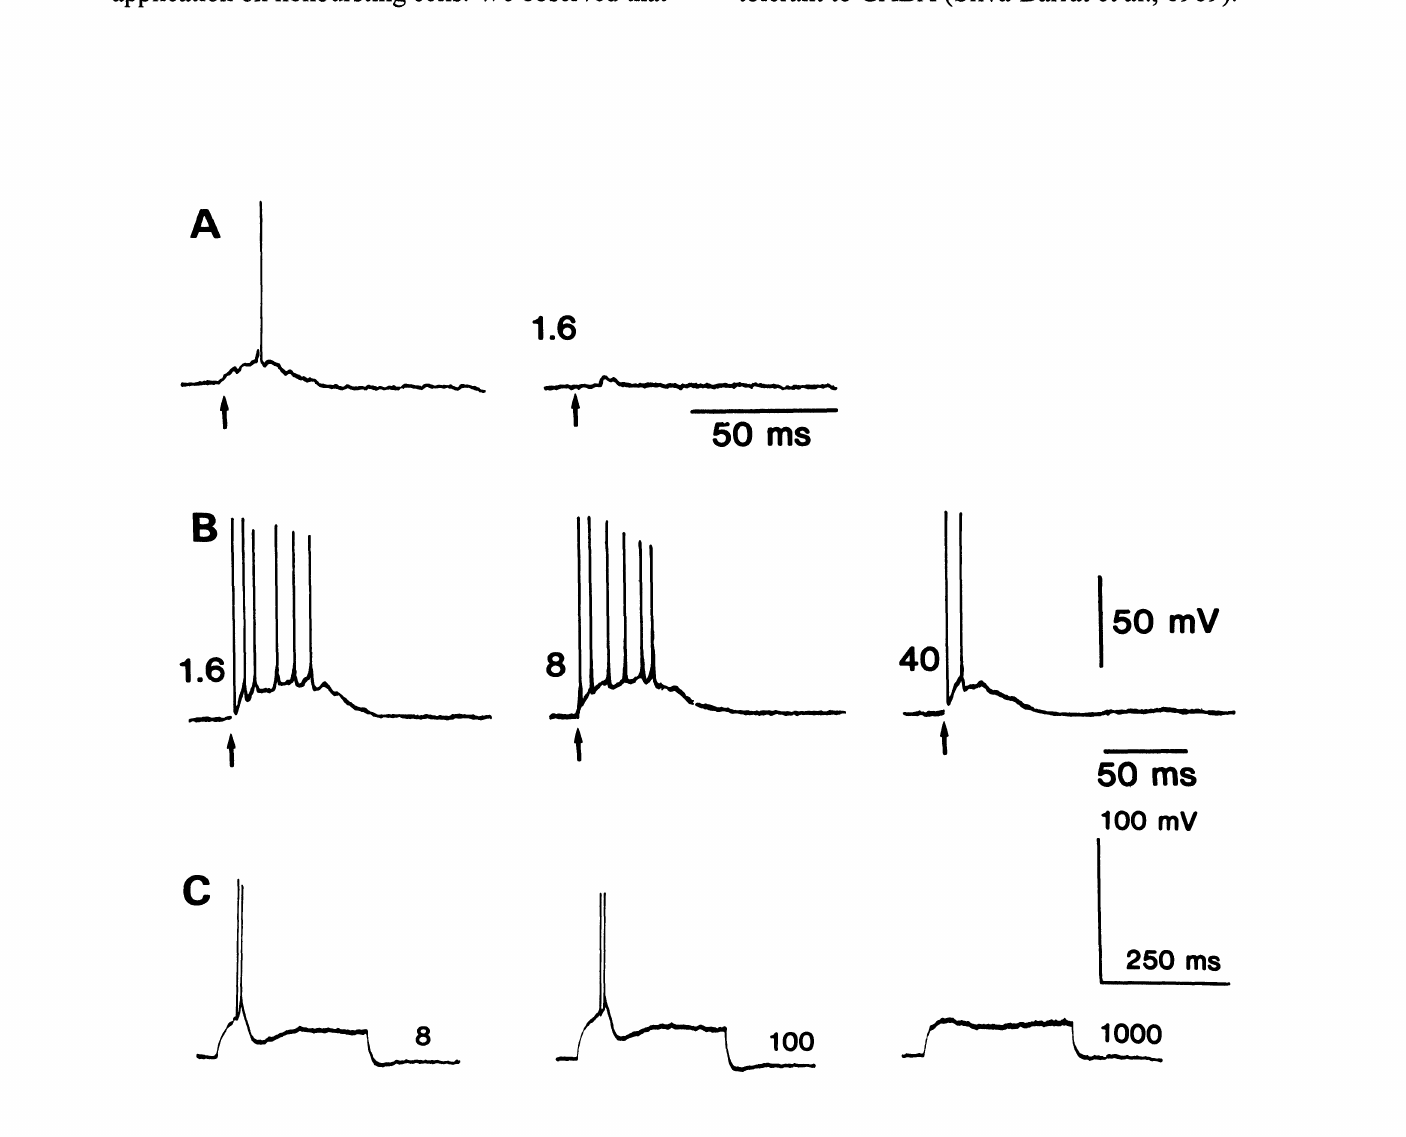
Fig. 2: GABA effects on synaptic potentials evoked by white matter stimulation (arrow). A: EPSPs induced in a saline-infused slice, before and during 1.6tM of GABA (5 min). B: paroxysmal depolarization shift induced in a slice obtained from a GABA-withdrawal syndrome rat during 1.6, 8, and 40 M of GABA application (5 min). Note the different time scales. C: Effects of GABA (5 min) on intrinsic bursts induced by intracellular depolarizing current (8, 100, and 1000tM). Note that intrinsic bursts are more resistant to GABA than to